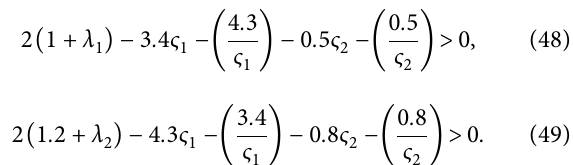
depicts the chaotic behavior, error and state trajectories of the derive FOMNN (46), and the response FOMNN (8) without an external controller, which are not synchronous.